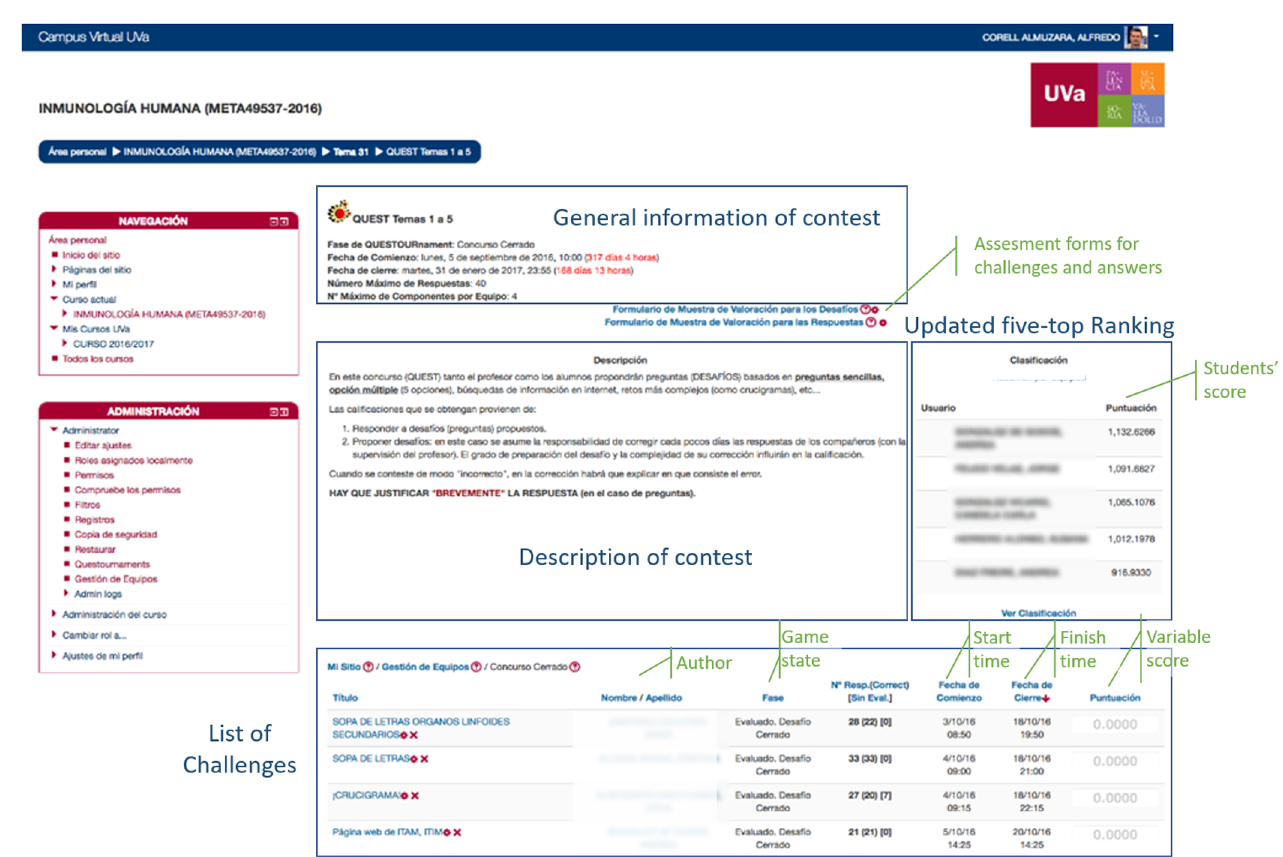
Fig 2. The QUESTOURnament tool in the Human Immunology course. The QUESTOURnament system permanently displays both an updated five-top ranking and the list of questions with their details (times, current score and game state-open or closed). General information and detailed description of the contest is also displayed as well as links to the assessment forms for challenges and